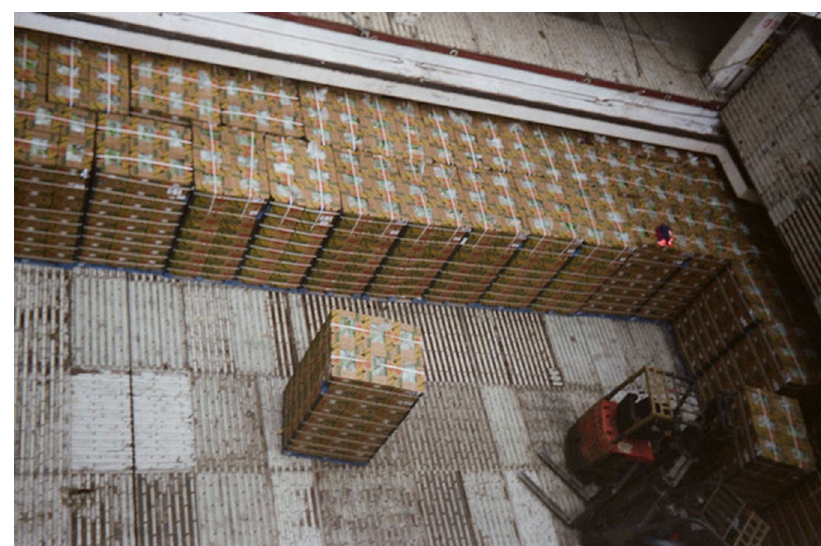
Fig. 4 Fruit in Port. Photograph was taken by a participant of fruit being loaded onto the vessel.